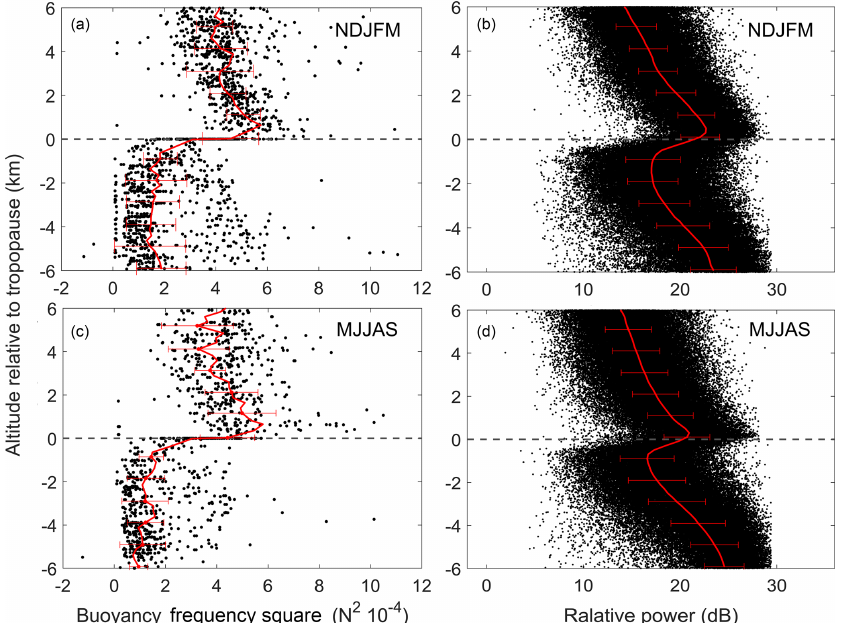
Figure 7. Scatterplots of (a, c) static stability ( N 2 ) and (b, d) radar-relative echo power as a function of altitude relative to the LRT (a, c) and RT (b, d) for extended winter (NDJFM) and summer (MJJAS) seasons for 2 specific years (2012–2013). Red lines in each panel denote the corresponding mean profiles, and the error bars indicate the standard deviations.